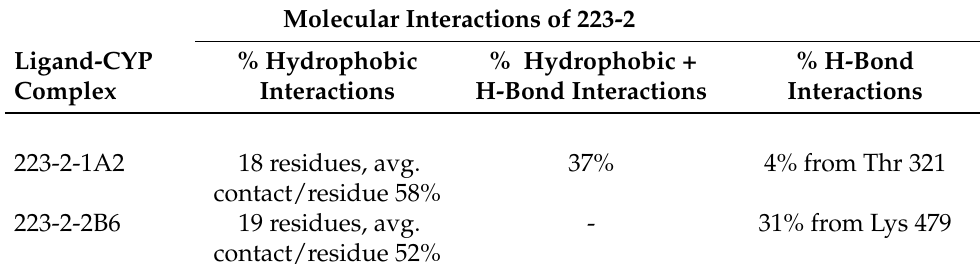
Table 1. Molecular interactions of 223-2 with active site residues of representative